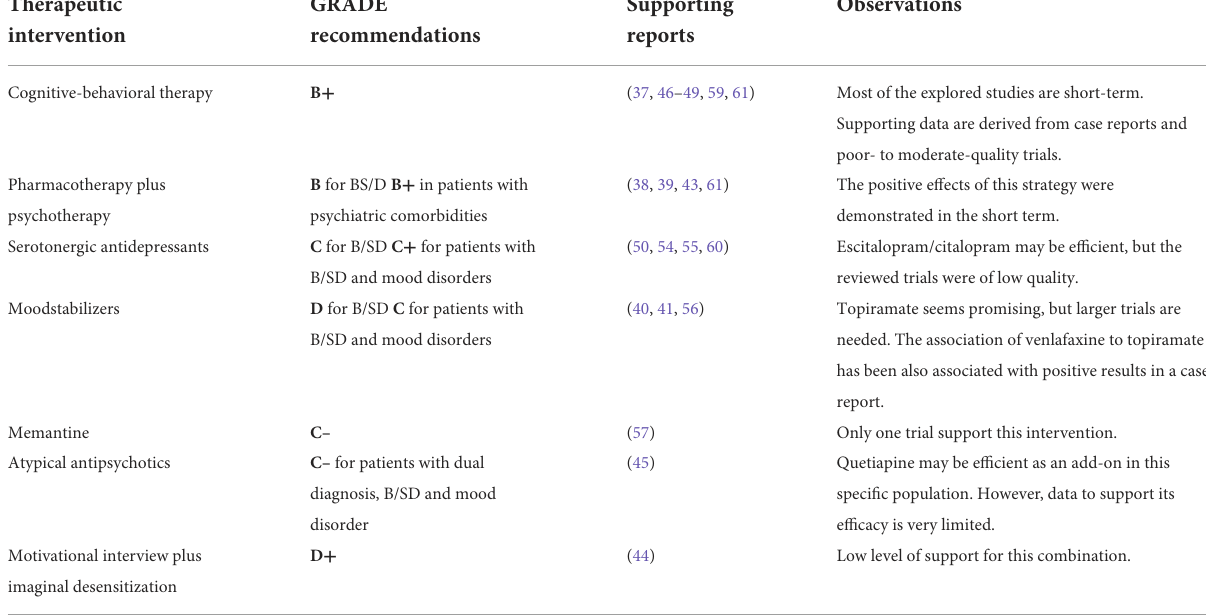
TABLE 5 Summary of GRADE recommendations for B/SD